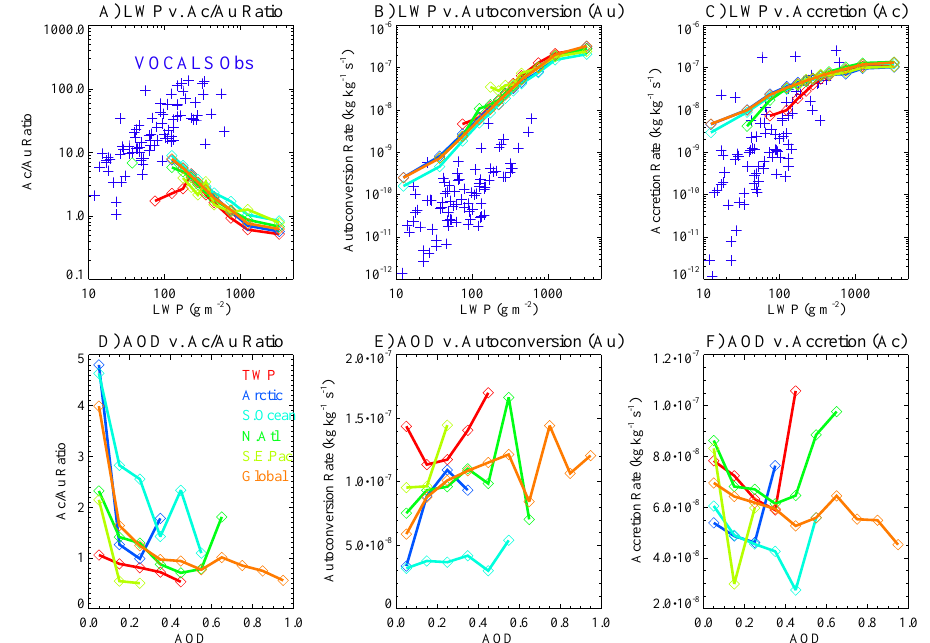
Fig. 5. GCM regional and global averages of vertically averaged (A) accretion/autoconversion ( A c /A u ) ratio v. LWP, (B) autoconversion ( A u ) rate v. LWP and (C) accretion ( A c ) rate v. LWP. Also shown are (D) A c /A u ratio, (E) ( A u and (F) A c v. AOD. Regions correspond to: tropical western Pacific (TWP: 20 ◦ S–20 ◦ N, 120–160 ◦ E), Arctic (65–80 ◦ N, all longitudes), Southern Ocean (65–60 ◦ S, all longitudes),